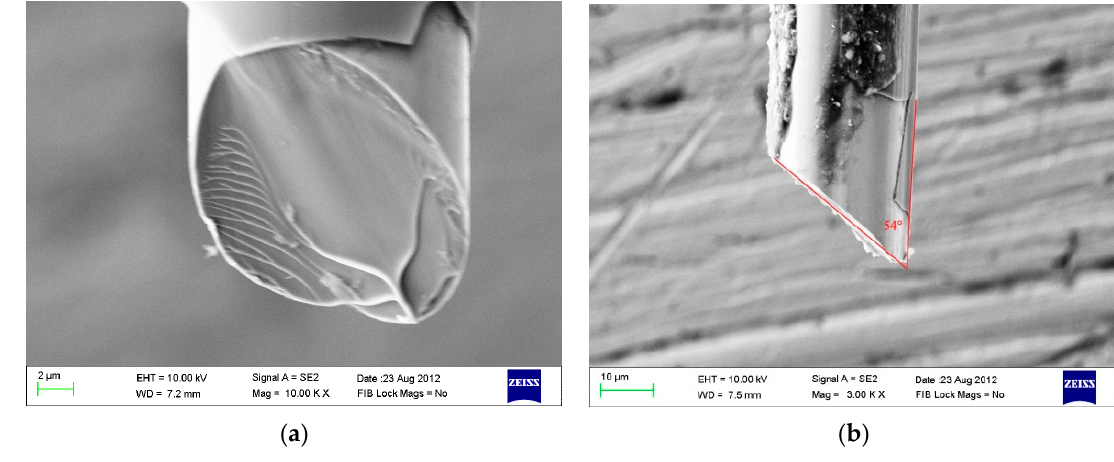
Figure 10. SEM micrograph of the fractured samples. ( a ) Fracture surface shows vein pattern; ( b ) fracture angle is about 54°.